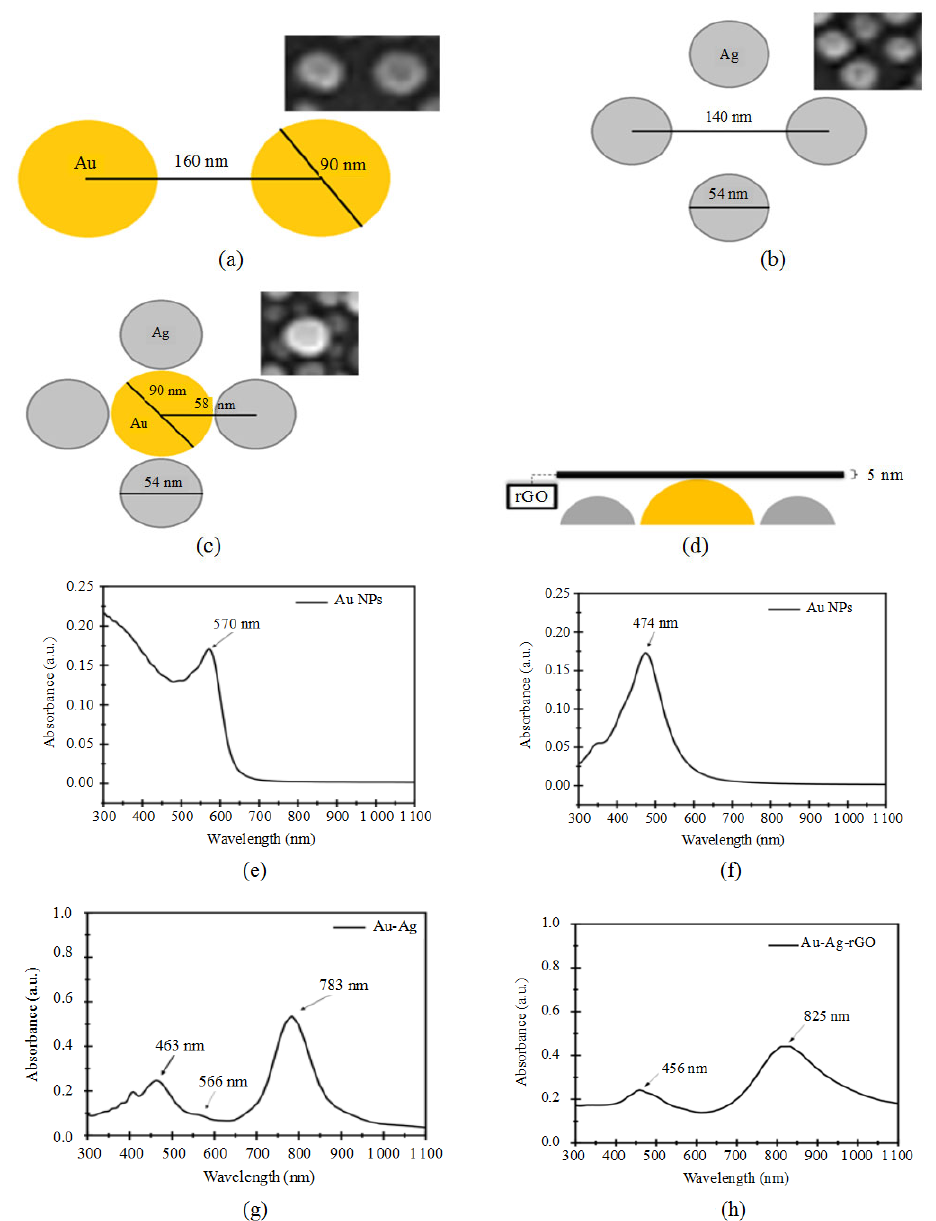
Fig. 3 FDTD simulation diagram for (a) monometallic Au, (b) monometallic Ag, (c) Au-Ag bimetallic, (d) Au-Ag bimetallic with rGO, and (e) – (h) normalized absorbances from 300 nm to 1 100 nm of the VIS-NIR excitation wavelength for Au, Ag, Au-Ag BMNPs, Au-Ag, and rGO composite